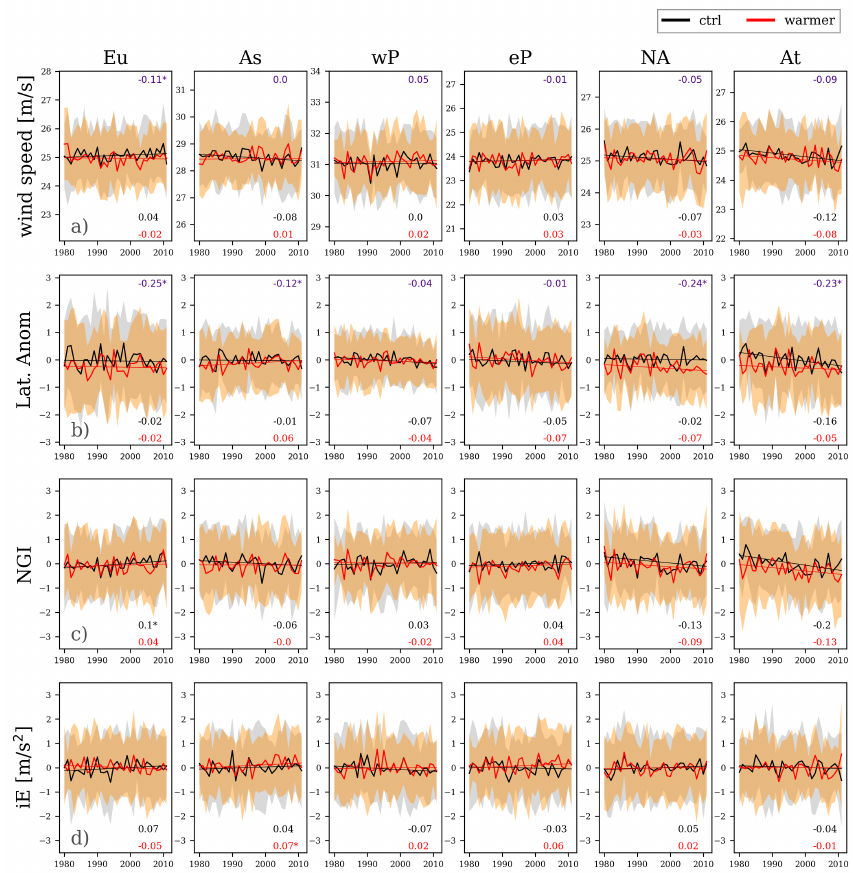
Figure 7. Time series of winter (DJF) mean indices of STJ variability for the SSTclim case. ( a ) STJ wind speed and ( b ) Latitudinal position, ( c ) NGI and ( d ) iE indices. Shaded areas indicate ± 1.5 times the standard deviation ( σ ) across ensemble members: gray shading for the control ensemble and orange for the low-sea ice Arctic Warming ensemble. Solid curves plot the indices ensemble mean value and the straight lines are the corresponding linear regressions. Trends values (values per decade) estimated from the linear regression are indicated at the bottom right of each panel. The differences between the ensemble means are indicated in the upper right of each panel of the wind speed and latitudinal position plots. Values are marked with ‘*’ when the differences or trends are significant at the 95% confidence level. Note differences in scale in some y